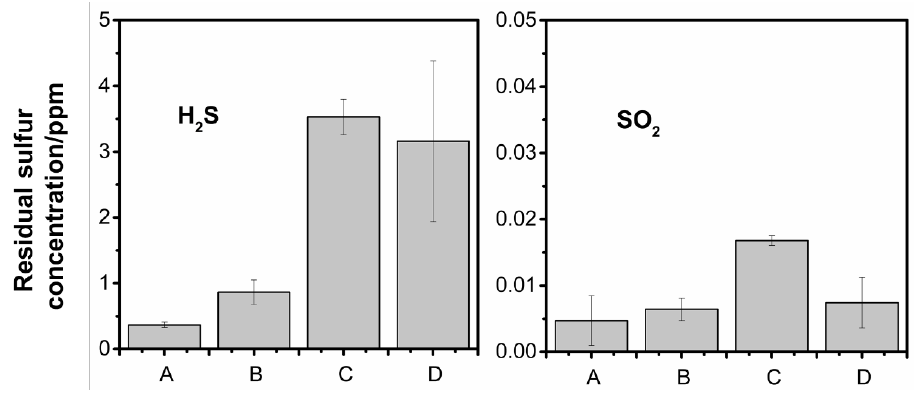
Figure 5. Residual sulfur concentrations measured with various H 2 S concentrations in a reducing gas with sorbent 15Mn8Mo at 600 ◦ C under dry or wet conditions, (A): 0.1 g sorbent and 100 mL/min gas flow with 2000 ppm H 2 S and no steam; (B): 0.2 g sorbent and 100 mL/min gas flow with 2000 ppm H 2 S and 6.5 vol.% steam; (C): 0.1 g sorbent and 100 mL/min gas flow with 2000 ppm H 2 S and 6.5 vol.% steam; (D): 0.2 g sorbent and 200 mL/min gas flow with 2000 ppm H 2 S and 6.5 vol.% steam.